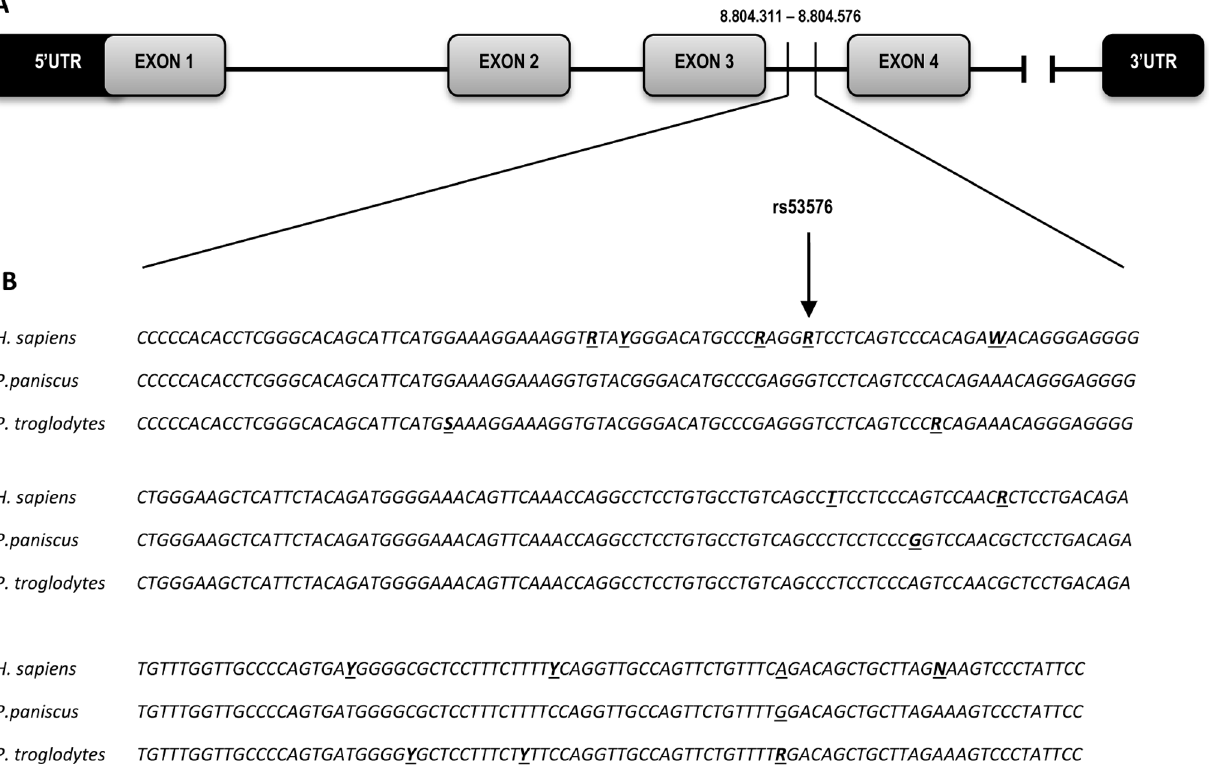
Figure 1. Human, chimpanzee and bonobo oxytocin receptor gene sequences surrounding rs53576 (Chr 3; NC_000003.11). Schematic (A) shows the position of the sequence in the third intron of the human OXTR (GRCh37.p13 gi|224589815). Inter-and intraspecific variation is shown in (B). Bold letters indicate single nucleotide polymorphisms indicated following IUPAC nucleotide codes. Underscores indicate positions of interspecific variation. (Human variation was identified using Ensembl dbSNP database.).